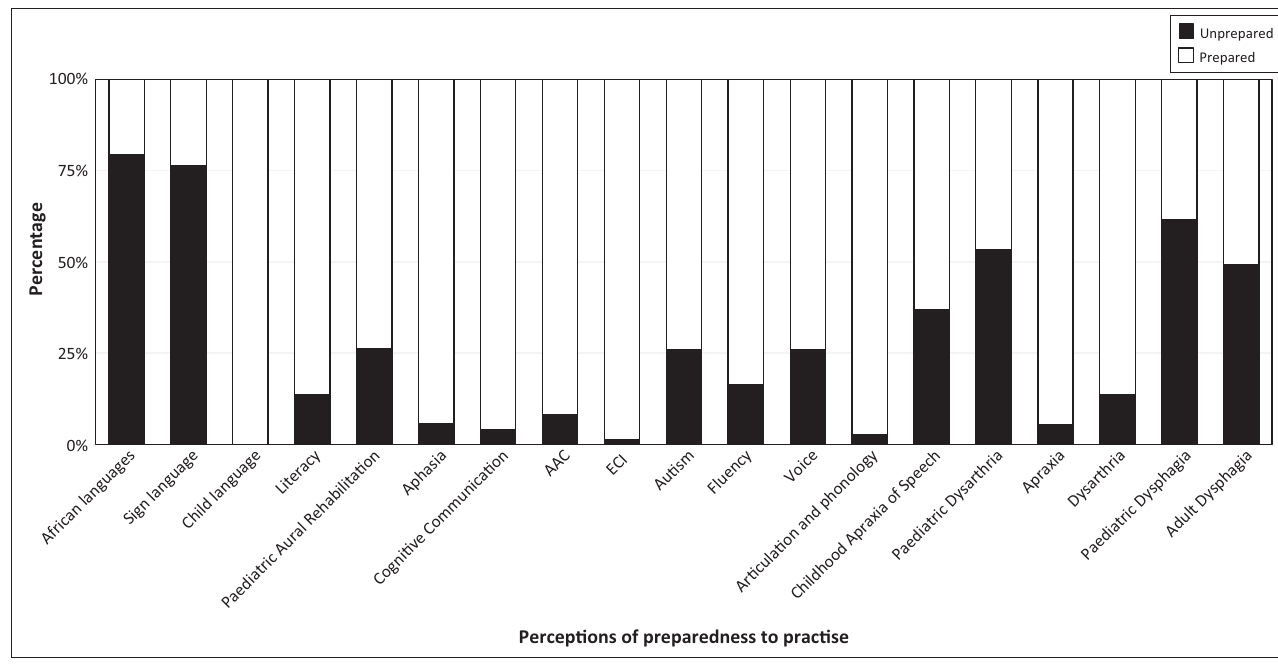
FIGURE 1: New graduates’ perceptions of preparedness to provide SLT services ( N = 73).